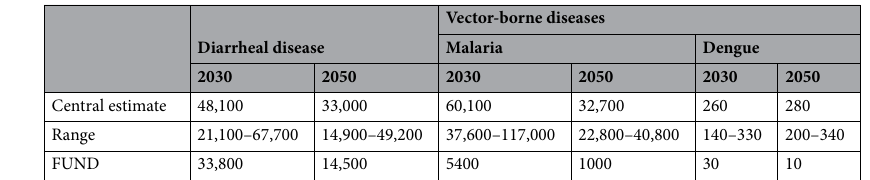
Table 3. Global excess mortality (number of deaths) due to climate change effects on diarrheal disease and vector-borne diseases for 2030 and 2050 under the A1B scenario from Hales et al. 12 . Range gives minimum and maximum values. Values from the FUND 3.9 19 model’s diarrheal disease and vector-borne impact components for the same time-points under A1B are also